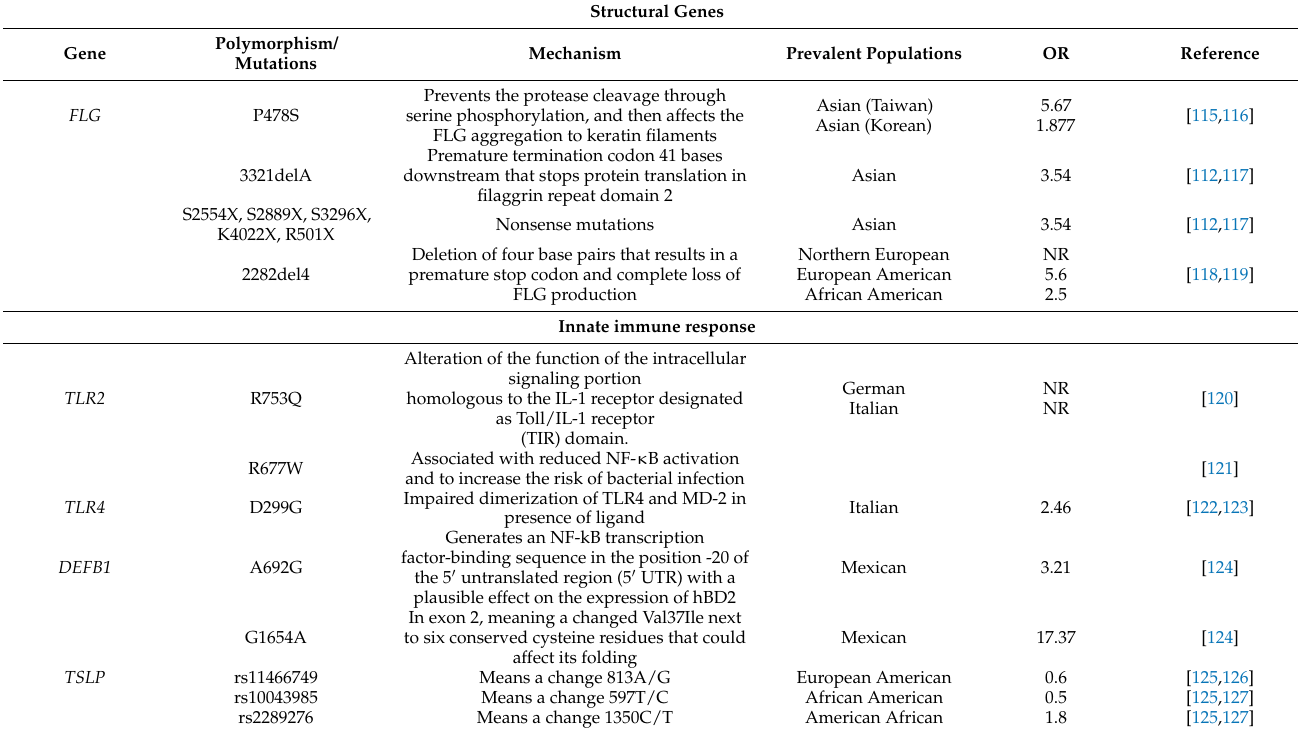
Table 1. Polymorphisms and mutations associated with AD with participation of